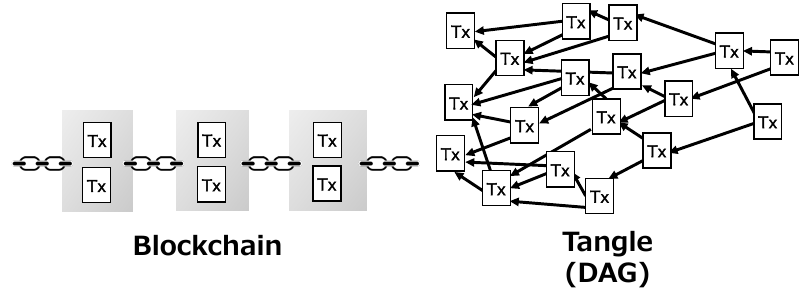
Figure 1. Comparison between blockchain and